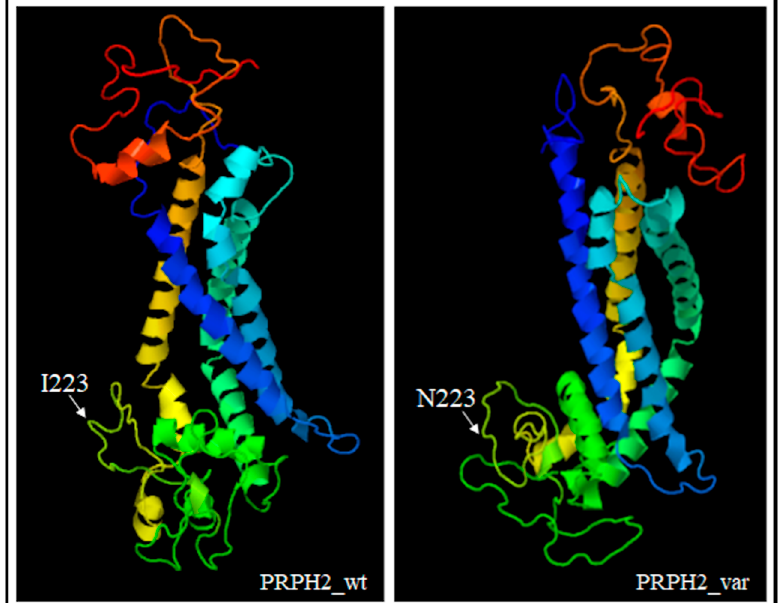
Figure 4. 3D models showing the different conformation of variant PRPH2 with respect to the wild-type protein. The position of the residue 223 has also been indicated. The prediction was based on ctxc5a (PDB header: cell invasion; PDB Title: crystal structure of human tetraspanin cd81). Wt: wild-type, var: variant.